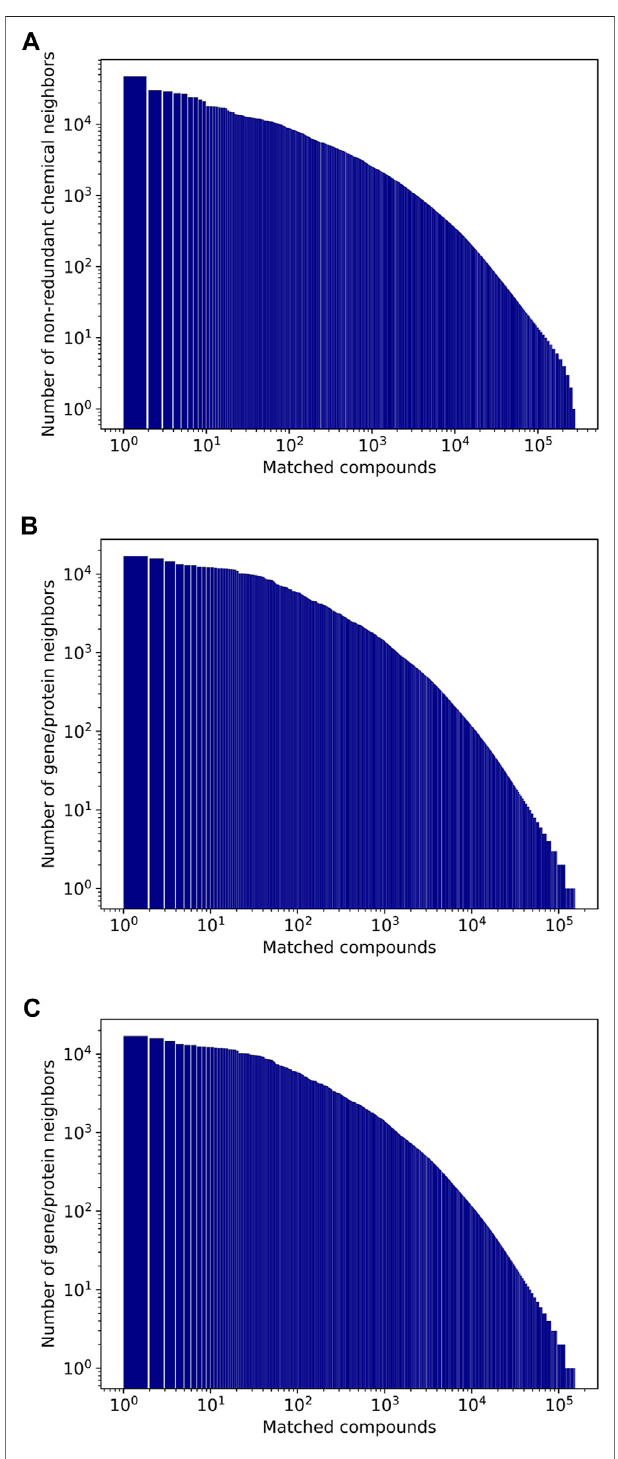
FIGURE 6 | Number of non-redundant neighbors of compounds (A), genes/proteins (B), and diseases (C).